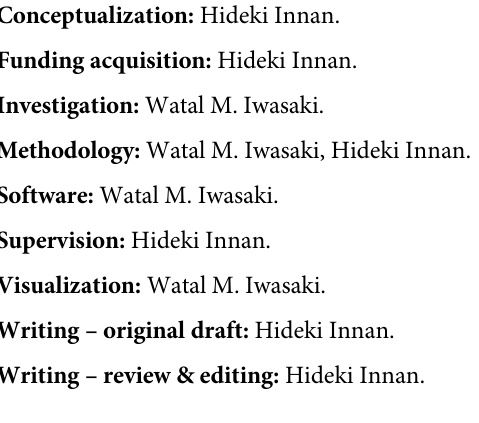
S2 Fig. 3D structures of simulated tumors assuming the von Neumann neighborhood in a regular lattice. All parameters except for the lattice/neighborhood are the same as in Fig 8. (TIF) S3 Fig. 3D structures of simulated tumors with a single strong driver mutation. Results for push methods 1 and 2 under constant-rate, step-function, and linear-function models are shown; The cells with the string driver mutation ( s = 9) are in red, while the others are in β blue. All parameters except for s are the same as in Fig 13. β